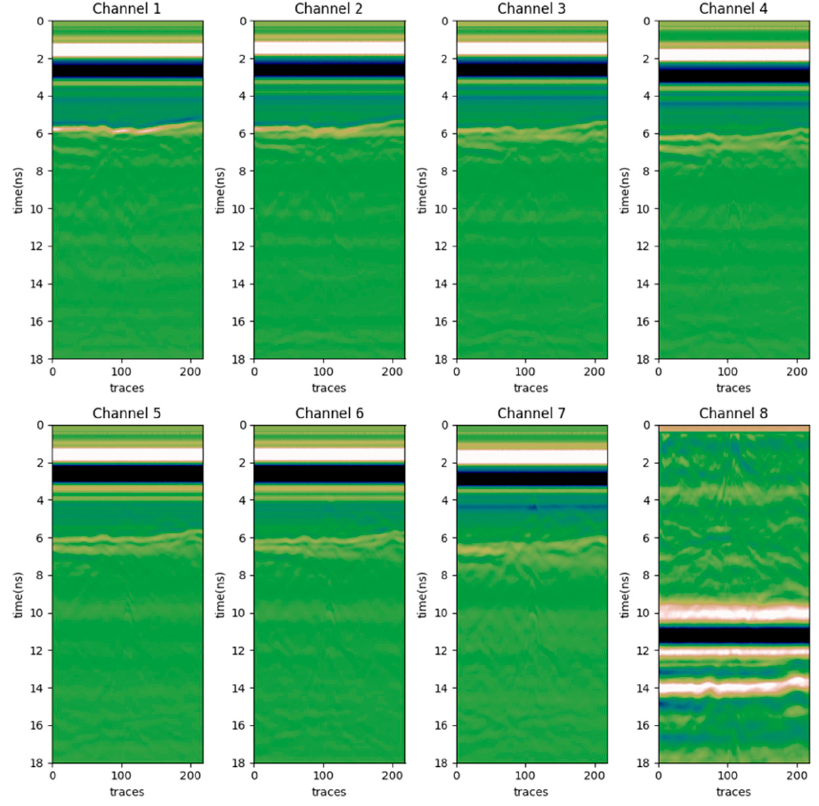
time and shows a strikingly lower maximum amplitude (~10 6 , arbitrary units) compared to the other channels (amplitude ~10 7 ).